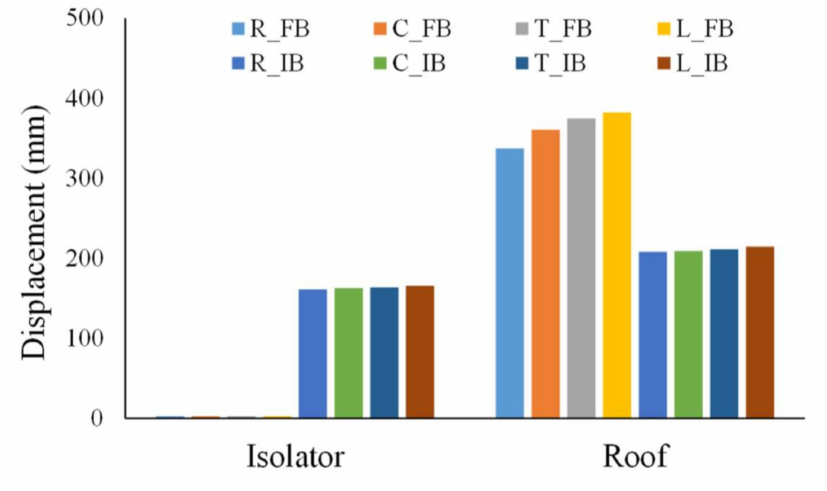
Figure 12. Roof and isolation level displacements for isolated- and fixed-base R, C, T, and L